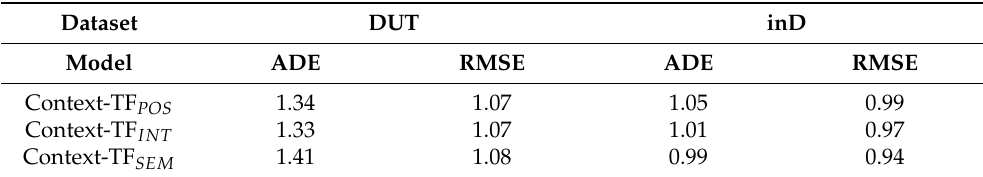
Table 2. Ablation study on the influence of individual contextual information on DUT and inD datasets. The prediction horizon is 5 s ahead. The reported scores are shown according to the evaluation metrics (ADE/RMSE) in meters. Lower scores are